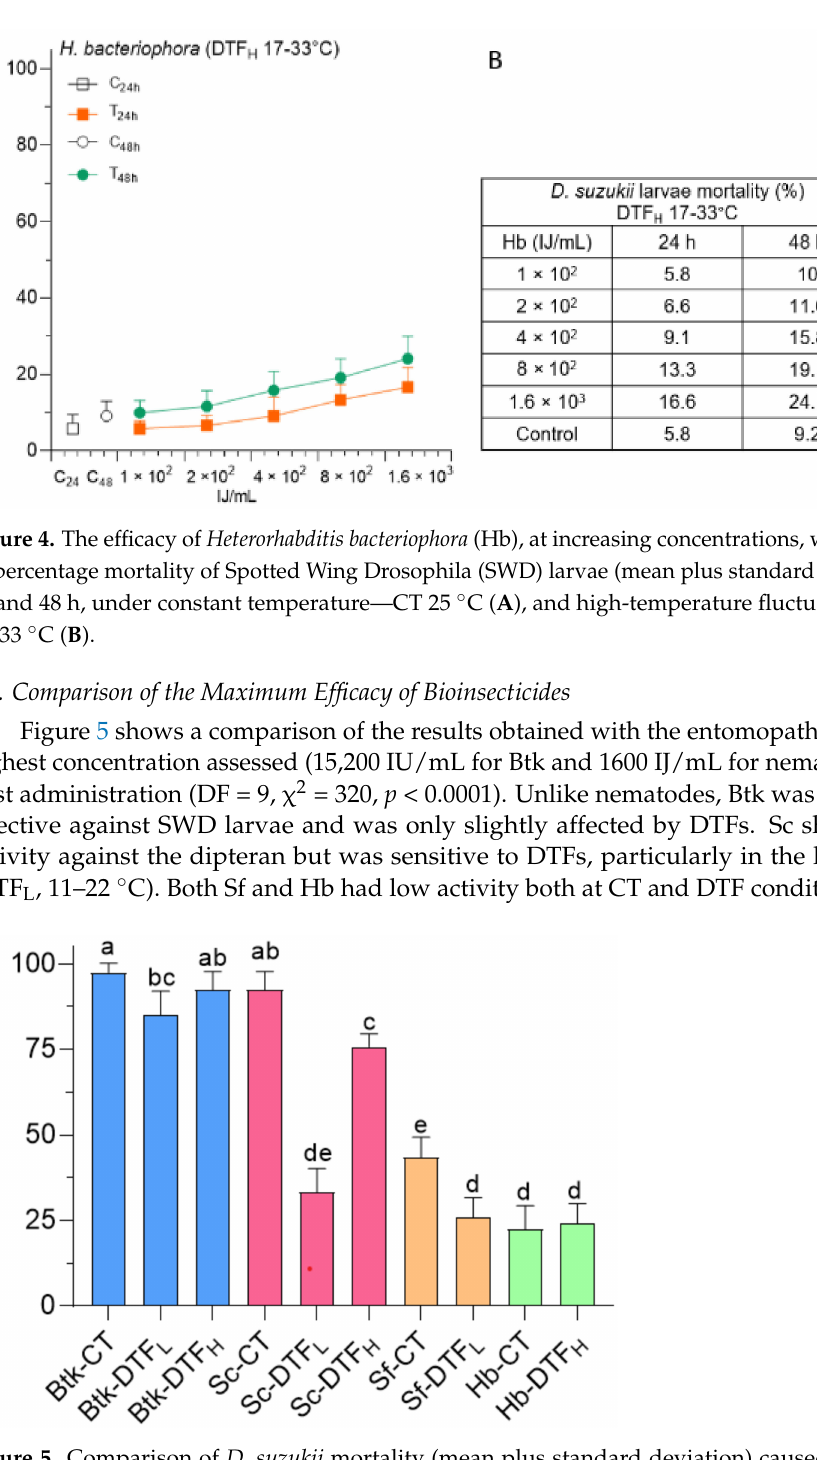
Figure 5. Comparison of D. suzukii mortality (mean plus standard deviation) caused by the four considered bioinsecticides at the highest concentration tested at 48 h at different temperature con- ditions (Btk-CT: B. thuringiensis var. kurstaki at a constant temperature, Btk-DTF L : B. thuringiensis var. kurstaki under low-temperature variation, Btk-DTF H : B. thuringiensis var. kurstaki under high- temperature variation; Sc-CT: S. carpocapsae at a constant temperature, Sc-DTF L : S. carpocapsae under low-temperature variation, Sc-DTF H : S. carpocapsae under high-temperature variation; Sf-CT: S. feltiae at a constant temperature, Sf-DTF L : S. feltiae under low-temperature variation; Hb-CT: H. bacteriophora at a constant temperature, Hb-DTF H : H. bacteriophora under high-temperature variation). Different letters above the bars indicate significant differences between estimated marginal means ( p <